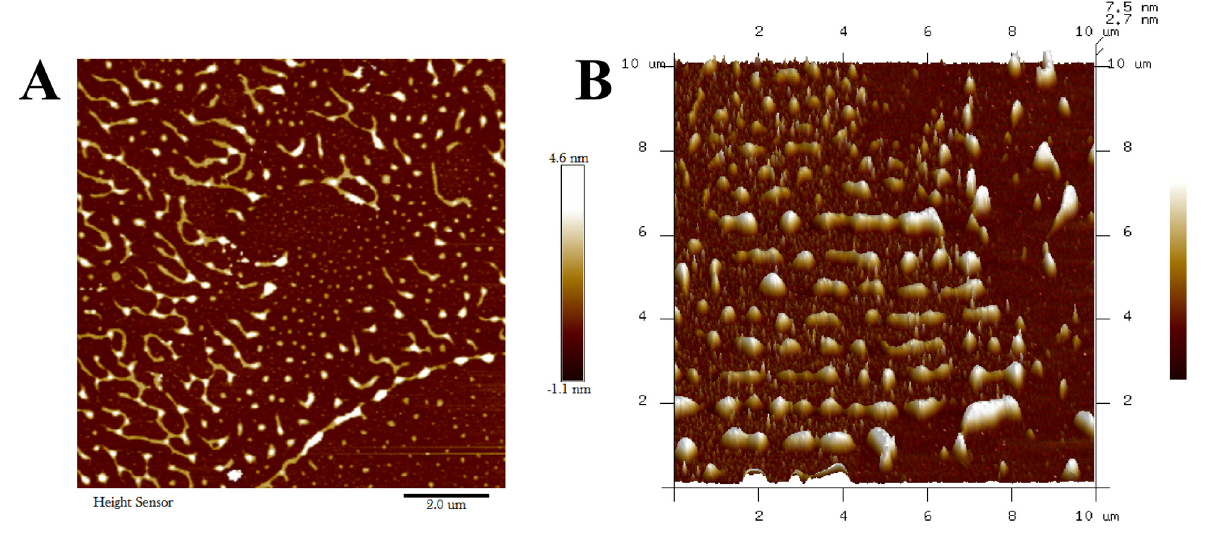
Figure 6. Atomic force microscopy images (( A ): planar image; ( B ): cubic image) of the EPS produced by Lpb. plantarum NMGL2.